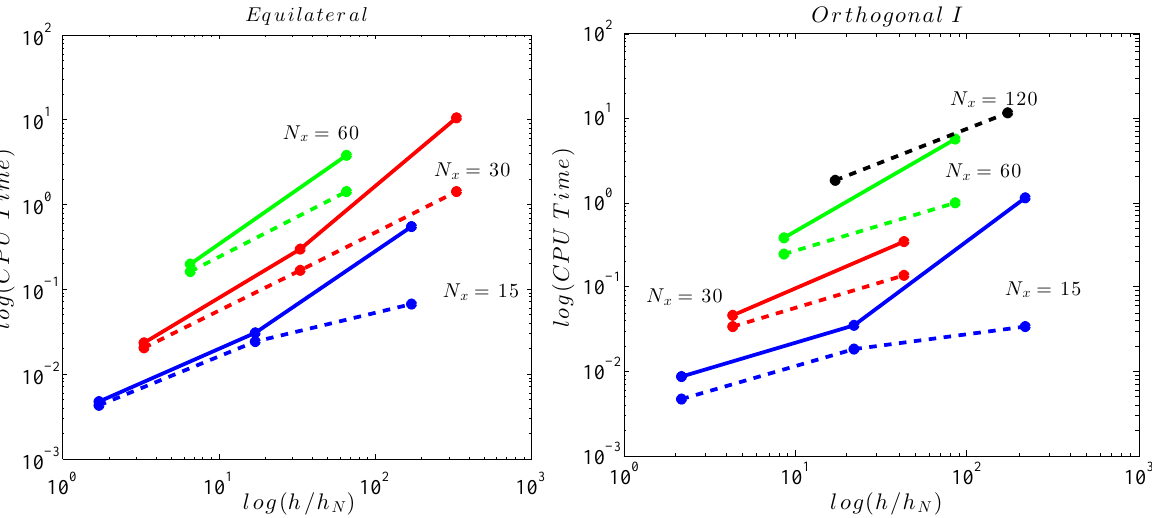
Figure 6. CPU time versus variable still water level to h N ratio for GMRES (solid line) and BiCGStab (dashed